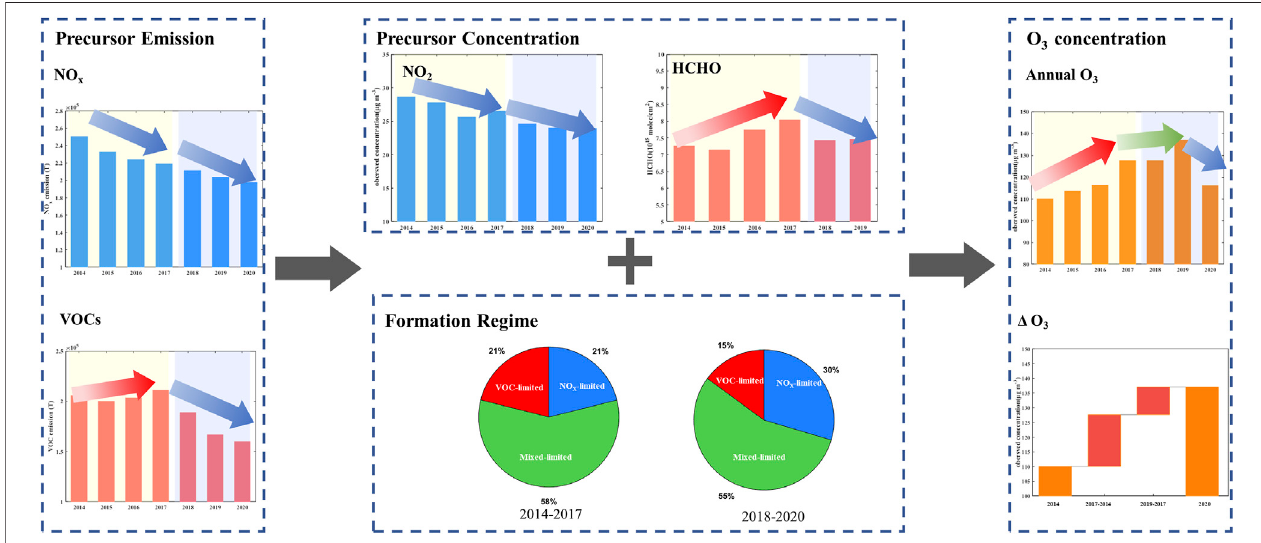
FIGURE 5 | The schematic diagram for illustrating changes of precursor emissions and concentrations, O 3 formation regime and O 3 concentration over the YRD region during the study period.